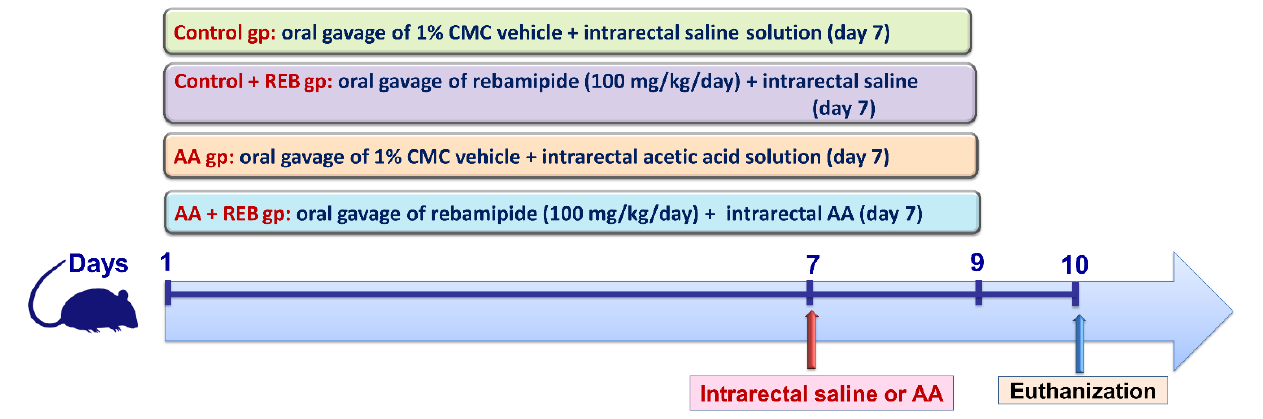
Figure 12. Schematic outline of the experimental study design. REB, rebamipide; AA, 3% acetic acid solution (3% v/v in saline).